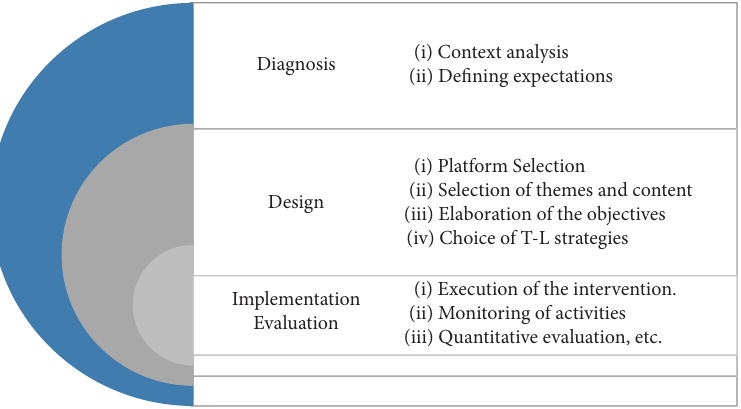
Figure 2: Instructional design of the technological innovation course. Table 2: Planning of activities.